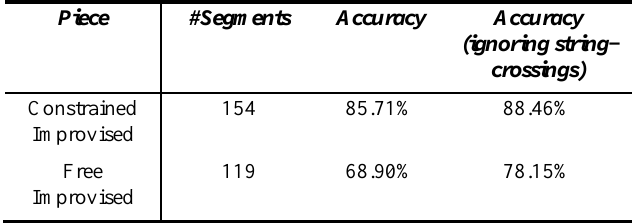
Table 5: Performance on the Improvised Pieces for Subject 2